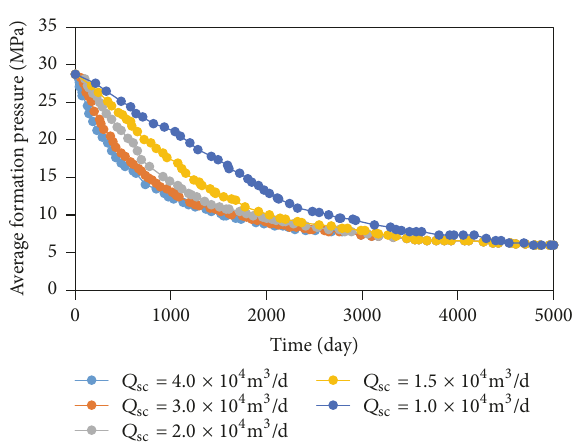
Figure 25: Average formation pressure under different initial gas rates.